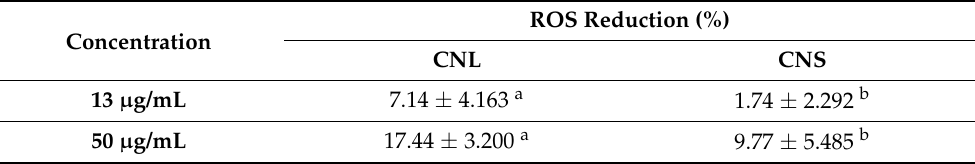
Table 2. Reduction of ROS level (%) in oxidative stress-induced HepG2 cells after pre-treatment with CNL and CNS as compared to untreated controls using DCFH-DA assay.